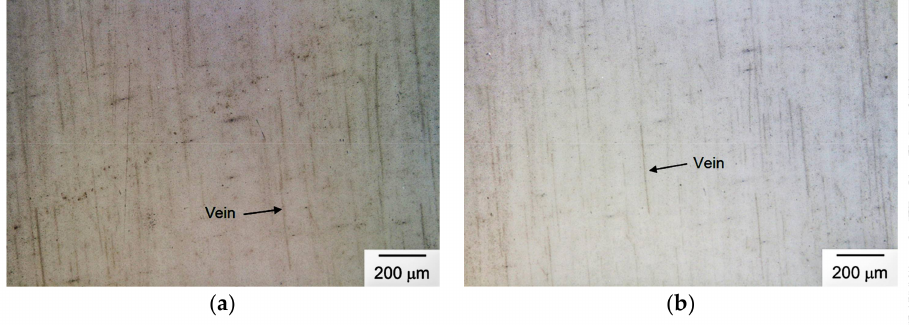
Figure 9. OM micrographs of barrier film after tensile bending with ( a ) a 10-mm and ( b ) a 5-mm curvature radius for 100 h.